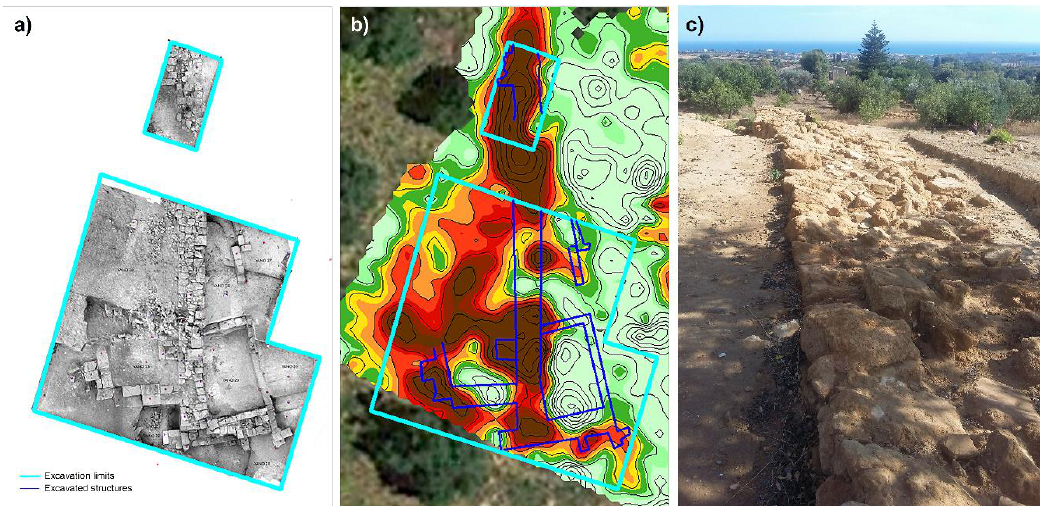
Figure 8. Orthophoto of the archaeological excavation in the southwestern sector of the theater (elaboration by A. Fino) ( a ), overlay of the relief of the structures on the resistivity map ( b ), analemma (first theater) in a picture taken from north to south ( c ).